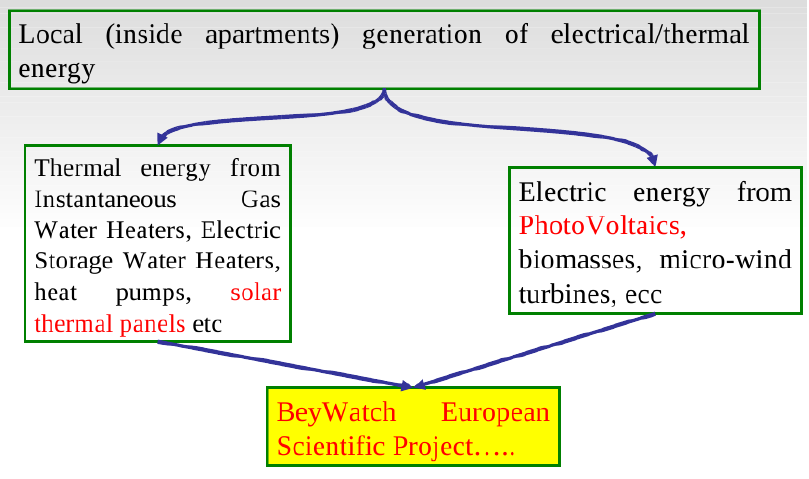
Figure 2. Distributed on site